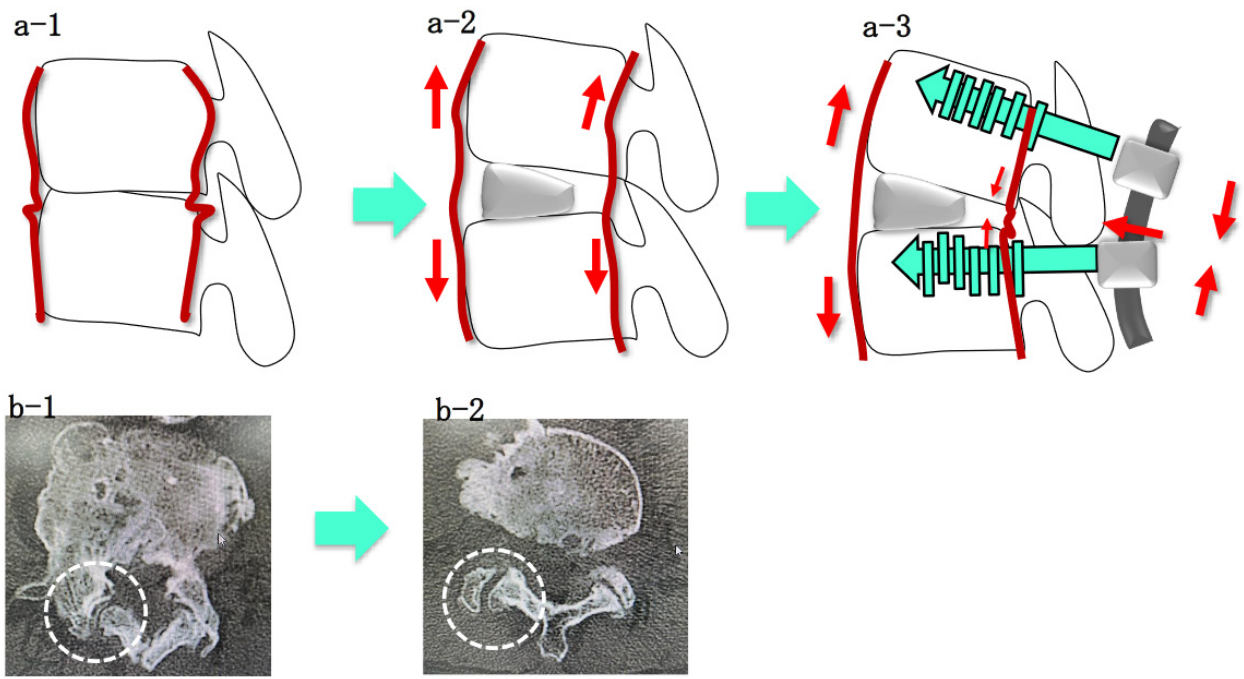
Figure 4. The mechanism of correction surgery using LLIF and PPS. Spreading the intervertebral space with insertion of a LLIF cage also opens the facet joints and provides indirect decompression of the intervertebral foramen. Subsequently, by applying a rod, lordosis can be obtained by closing the facet joint. Therefore, even if PPS procedure without Ponte osteotomy was undertaken, sufficient correction is possible without causing nerve root impingement ( a-1 , a-2 , a-3 ). The contracture facet joints were released and dilated with insertion of LLIF. LLIF procedure can dissociate not only the anterior element, but also the posterior element indirectly ( b-1 , b-2 ). LLIF: lateral lumbar interbody fusion; PPS: percutaneous pedicle screw